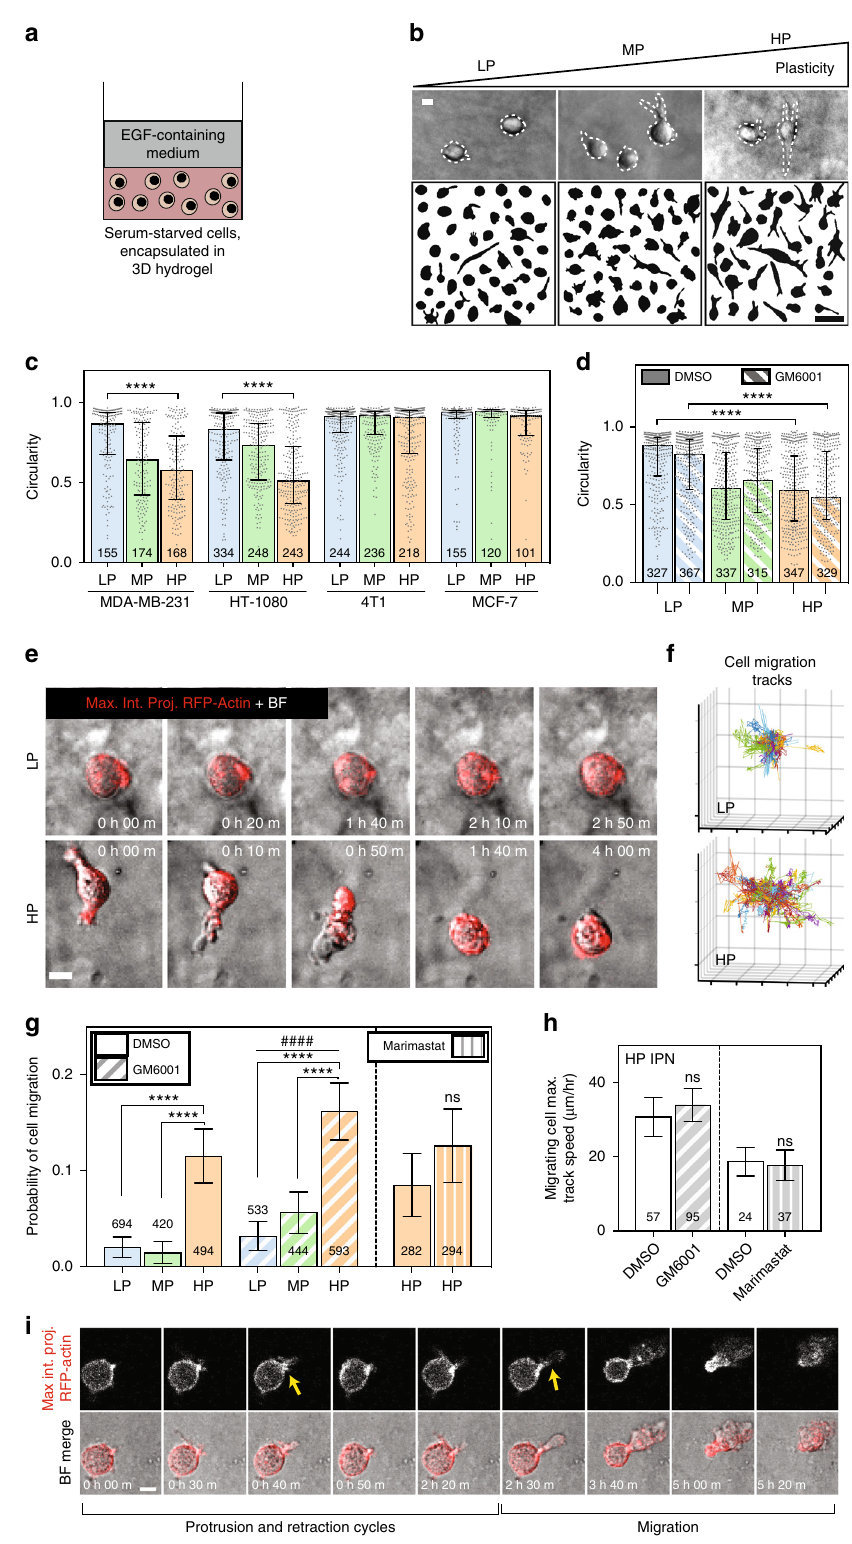
in cells in both LP and HP IPNs, but these puncta more fre- quently matured into elongated protrusions in HP IPNs (Fig. 3a and Supplementary Movies 10, 11). Cells in HP IPNs were ~50% more likely than cells in LP IPNs to extend protrusions (Fig. 3b IPNs were longer (10 – 20 μ m or more in length) and